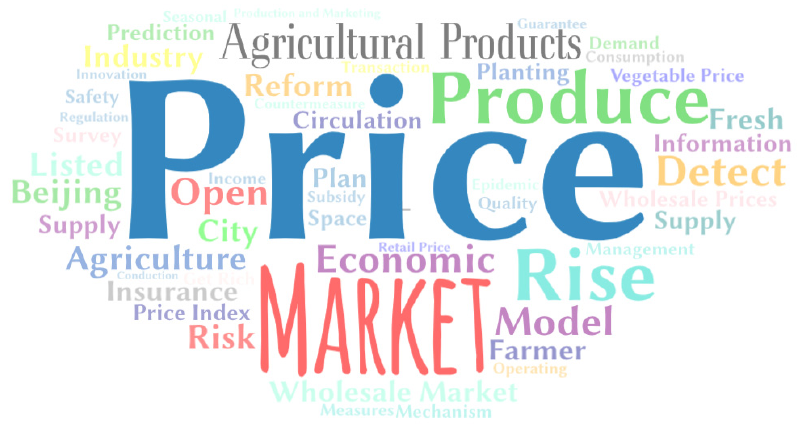
Figure 9. Statistics of High-frequency Words.